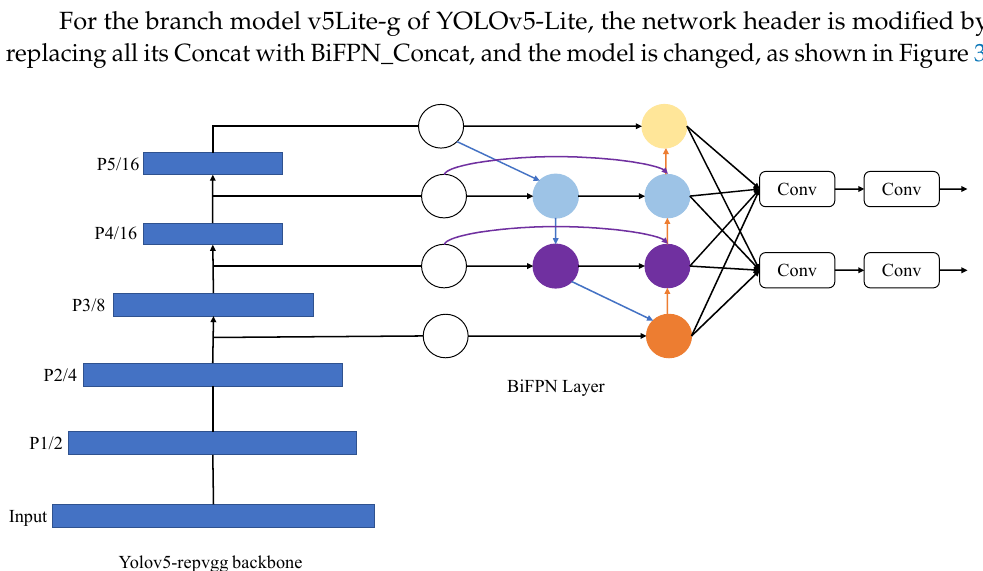
Figure 3. YOLOv5-Lite modified network structure